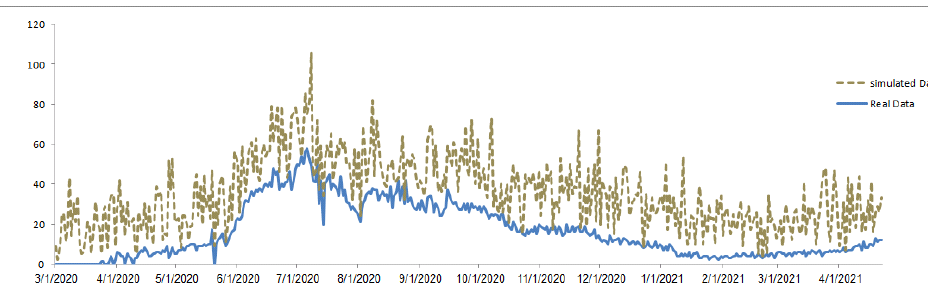
Figure 15. Comparison between real and simulated data for infected class in the considered model.